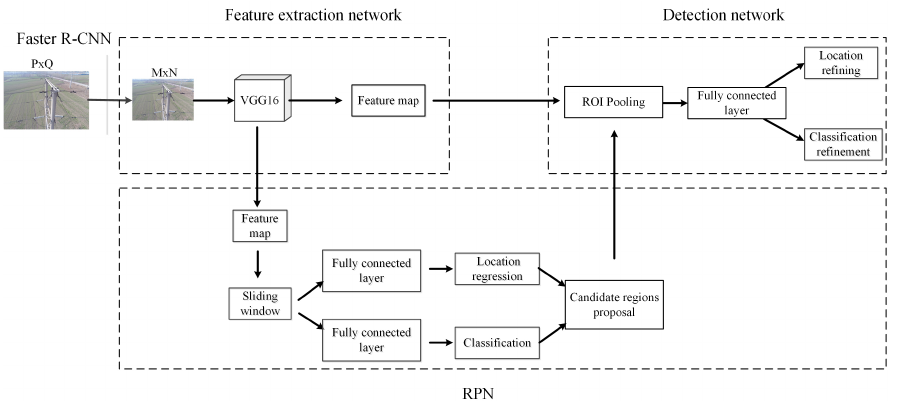
Figure 3. Architecture of Faster R-CNN. To improve readability, we take the rust detection problem as the